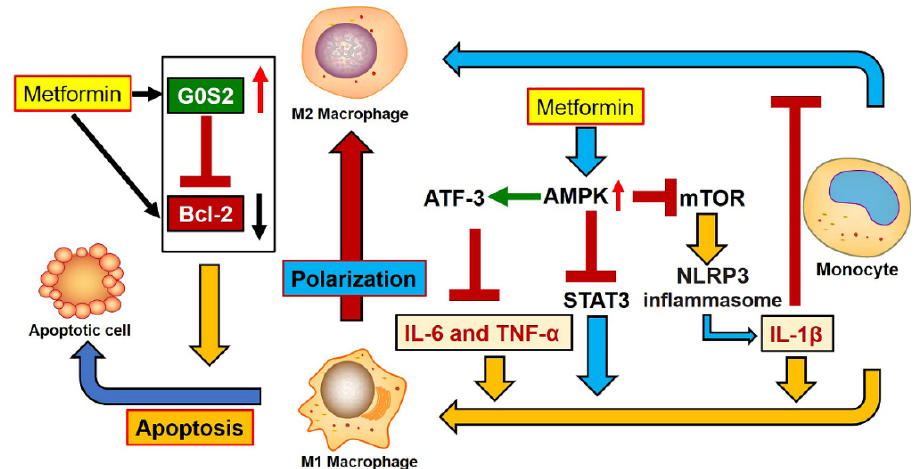
Figure 7. A working model of the anti-inflammatory mechanism for metformin on macrophages. The model describes how metformin promotes M2 macrophage activation through induction of AMPK activation, as previously proposed [15,17,18]. Synergistically, the results from this study support a novel anti-inflammatory mechanism of metformin on macrophages by inducing apoptosis of M1 macrophages through activation of G0S2 and inhibition of Bcl-2.